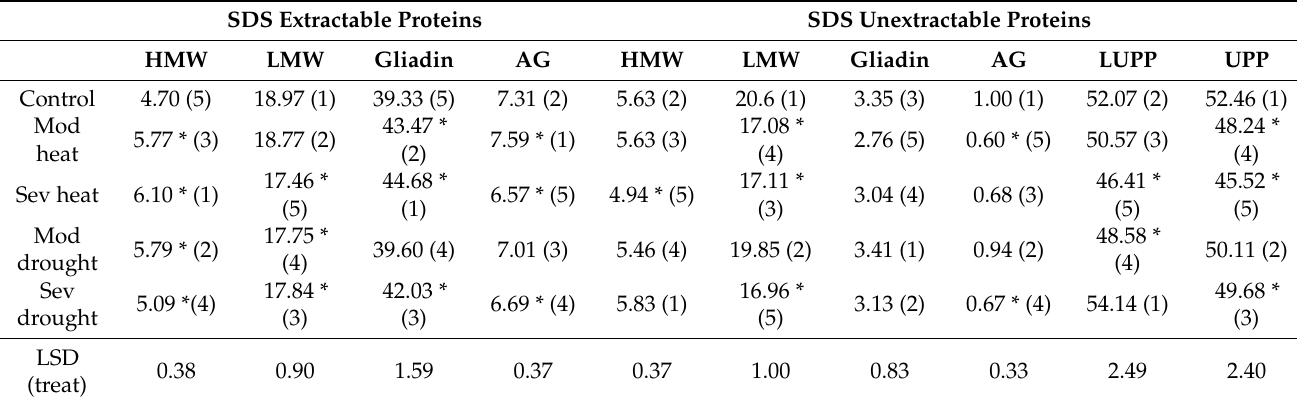
Table 4. SDS extractable and unextractable gluten protein fractions (%) averaged for six cultivars and two seasons. SDS Extractable